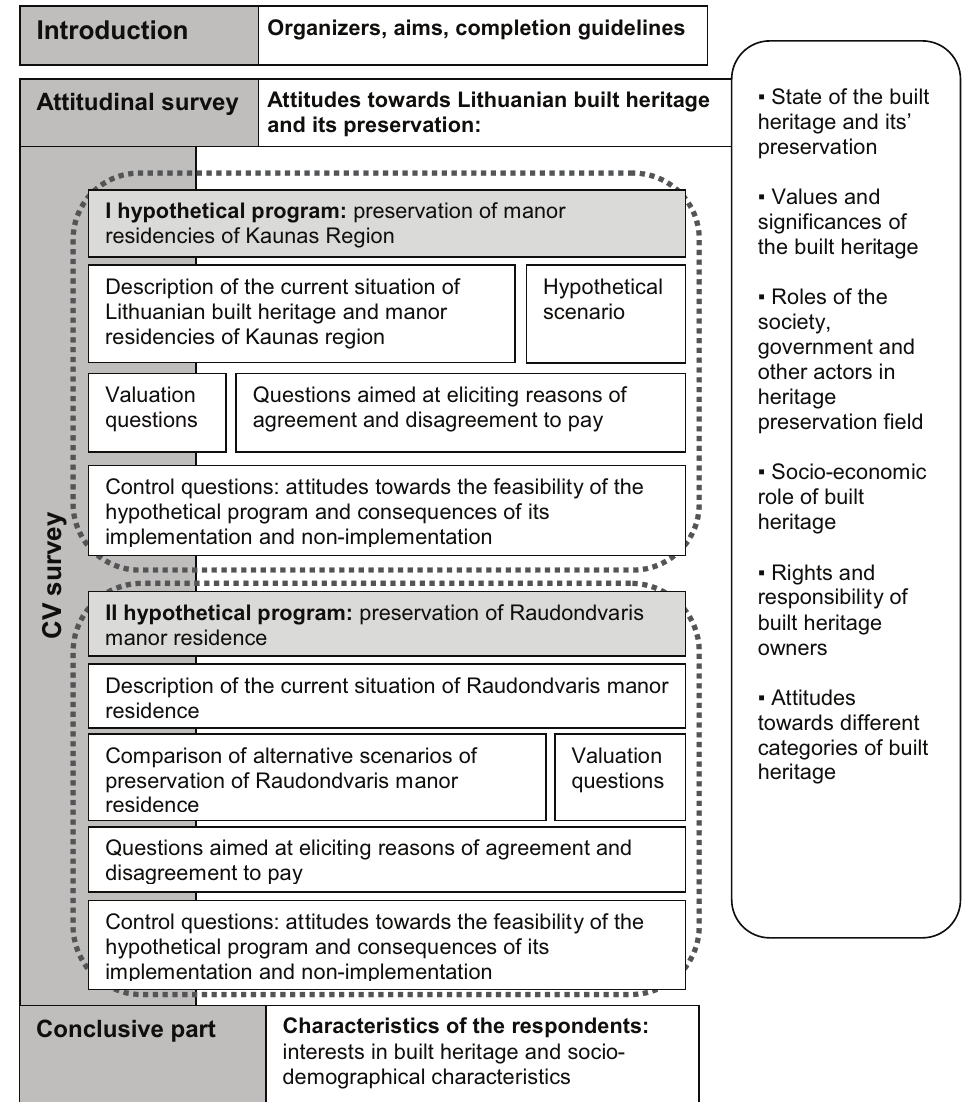
figure 4. The structure and contents of the questionnaire